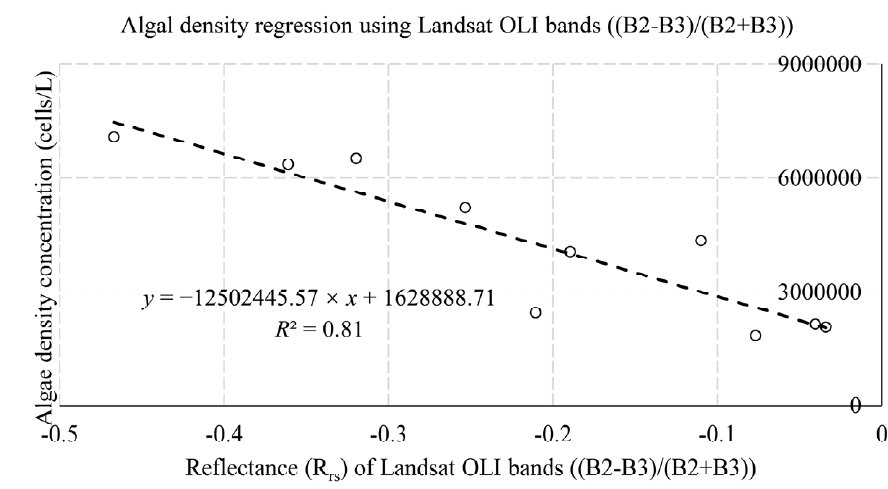
Figure 6. In situ-derived algal density and Landsat OLI bands reflectance from training datasets.